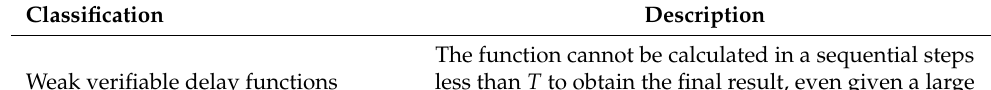
Table 2. Classification of verifiable delay